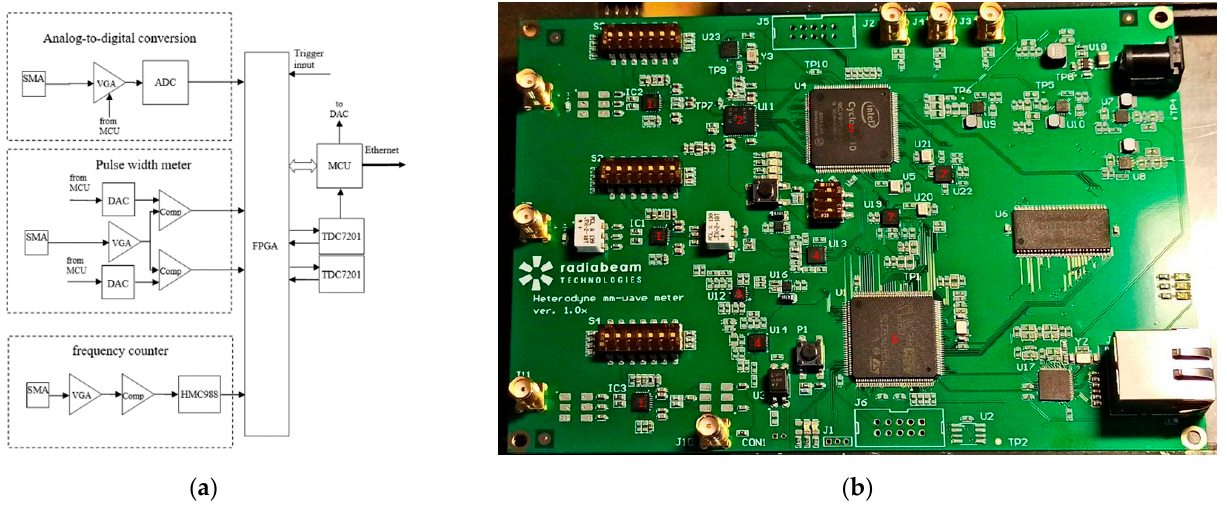
Figure 11. Block diagram of the updated capture module ( a ): SMA—coaxial RF connector, VGA—variable gain amplifier, Comp—high-speed comparator, HMC988—frequency divider, TDC7201—time-to-digital converter, DAC—digital-to-analog converter, ADC—analog-to-digital converter, MCU—microcontroller unit, FPGA—field-programmable gate array. Pulse-signal digitizer module ( b ).